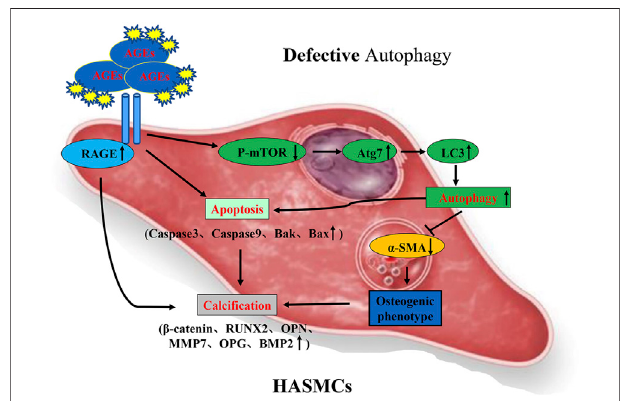
FIGURE 9 | Possible mechanism of AGEs-induced calci fi cation in HASMCs via the induction of autophagy and apoptosis.